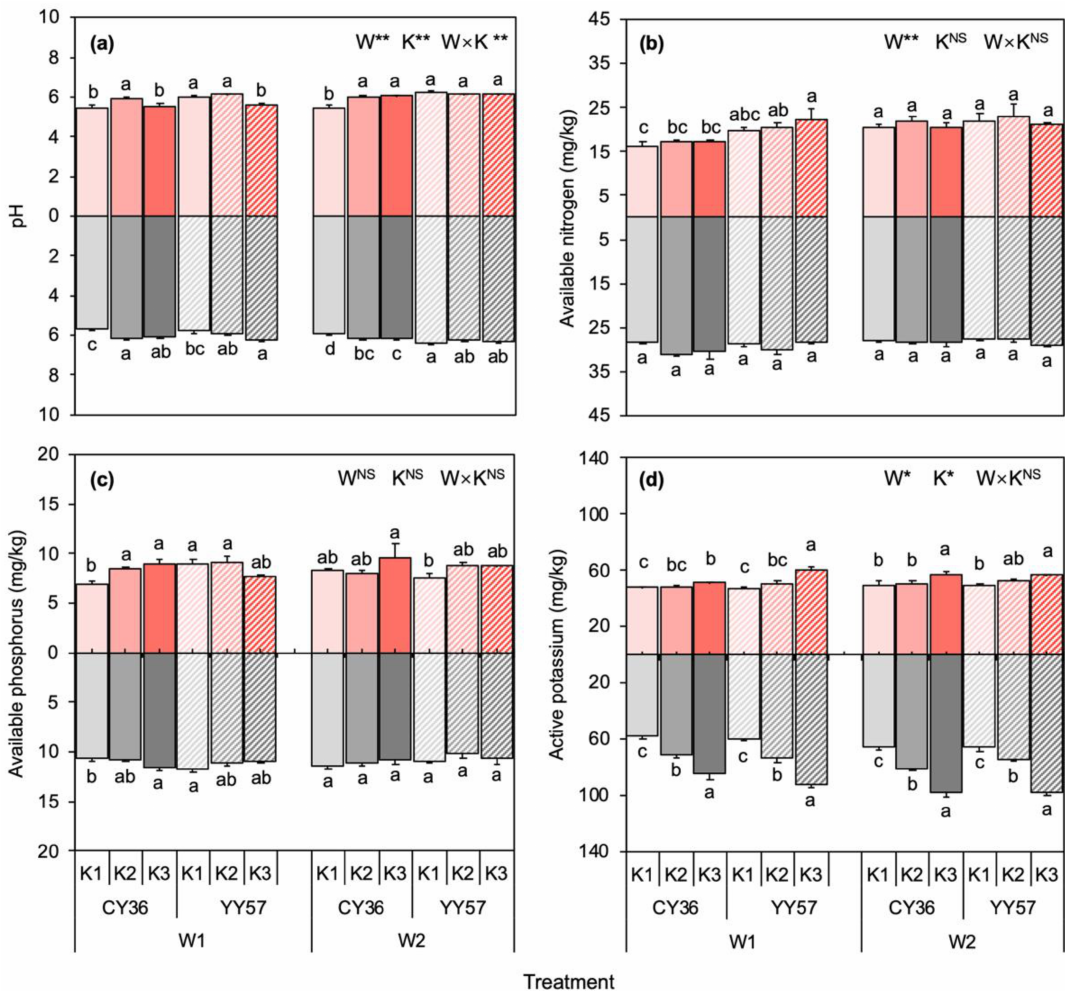
Figure 5. Effects of K supply level on the rhizosphere (values above x -axis) and non-rhizosphere (values below the x -axis) ( a ) pH, ( b ) available nitrogen, ( c ) available phosphorus, and ( d ) available potassium content of two rapeseed cultivars under different soil moisture content. W1 and W2 indicate 40% and 75% water-holding capacity, respectively, and K1, K2, and K3 indicate K (K 2 O) applications rates 0, 80, and 160 mg · kg − 1 , respectively. Means and standard errors ( n = 4). Different small letters mean significant differences in Duncan multiple range tests among different treatments at 5% level ( p < 0.05). Two-way analysis of variance (ANOVA) was performed to evaluate the effects of soil moisture content (W), K-fertilizer (K), and their interactions (W × K). NS means non-significant. * and ** indicate significant differences at p < 0.05 and p < 0.01 probability levels,